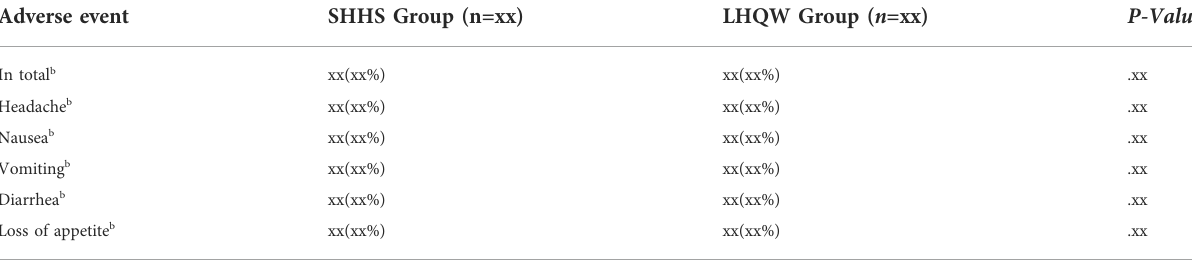
TABLE 5 Analysis of the adverse events in the full analysis